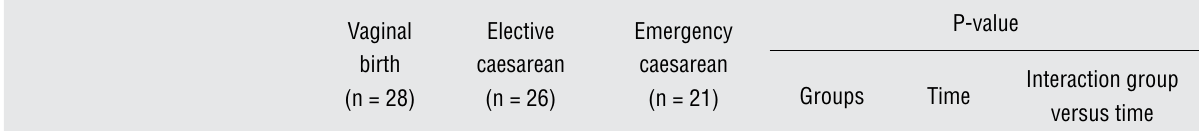
Table 1 - Puerperal and gestational urinary symptoms evaluated through ICIQ-OAB and ICIQ-UI SF. Vaginal Elective